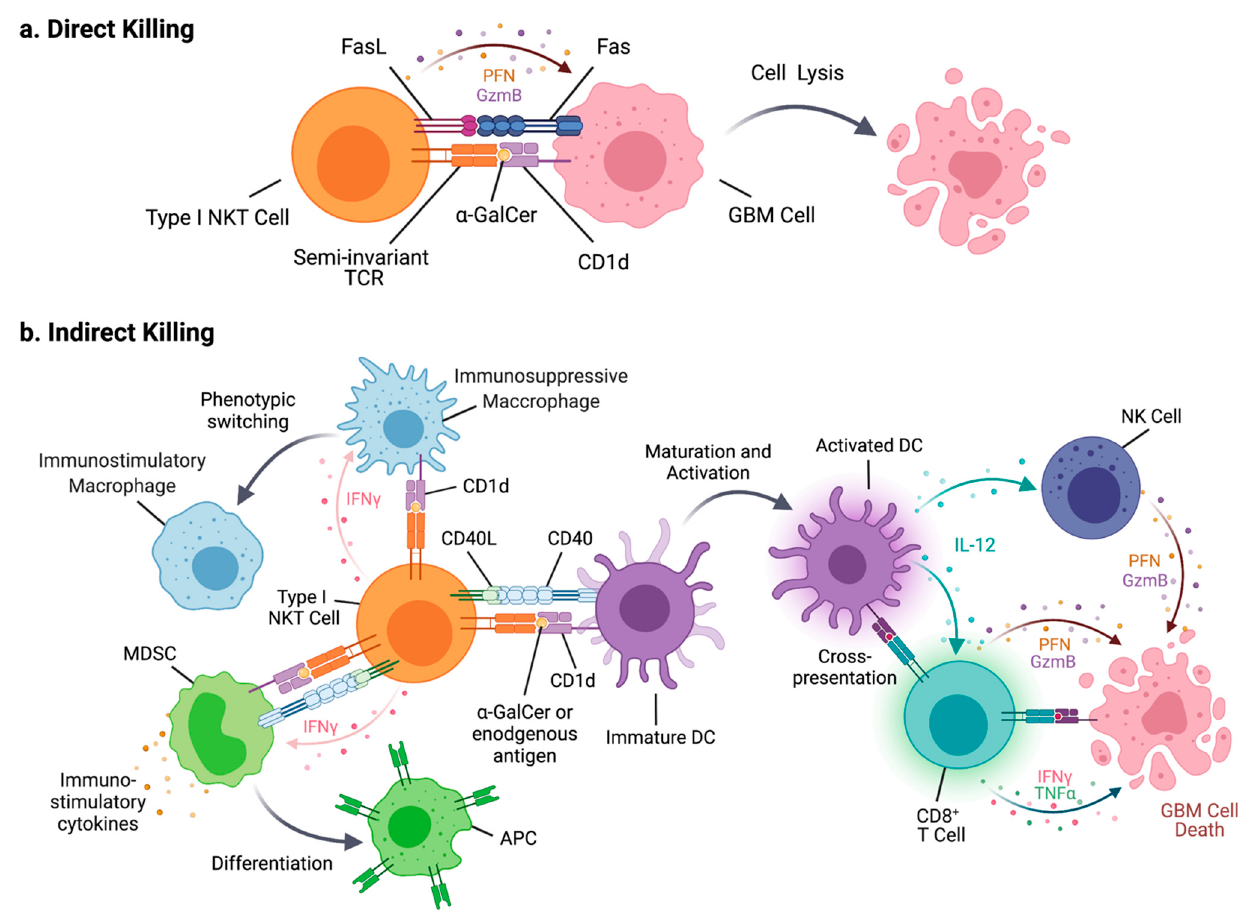
Figure 1. Potential mechanisms of type I NKT cell-mediated glioblastoma cell lysis. ( a ) Type I NKT cells can directly lyse GBM cells expressing CD1d presenting exogenous lipid antigens such as α -GalCer via Fas/FasL interaction and perforin (PFN) and granzyme B (GzmB) release. ( b ) Type I NKT cells can indirectly induce GBM cell lysis when presented with lipid antigens via CD1d on DCs. Through interaction with type I NKT cells, DCs mature and activate, cross-present antigens to CD8 + T cells, and secrete IL-12 to induce CD8 + T cells and NK cells to directly lyse GBM cells. Additionally, activated type I NKT cells can induce macrophages to switch from an immunosuppressive to an immunostimulatory phenotype when macrophages present lipid antigens in the context of CD1d. Type I NKT cells can interact with MDSCs via TCR-CD1d interaction and CD40–CD40 ligand (CD40L) interaction to induce MDSC secretion of pro-inflammatory cytokines and differentiation into antigen-presenting cells (APCs).